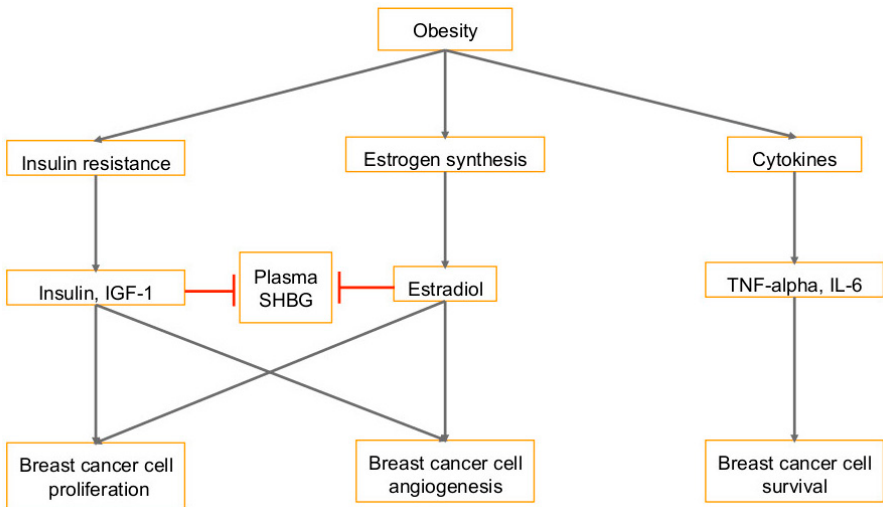
Figure 1. Pathways that link breast cancer with obesity: Several consequences of obesity, such as insulin resistance, higher levels of circulating estrogen, and secreted cytokines play a role in the development of breast cancer. Insulin and IGF-1 promote proliferation and angiogenesis by activating the PI3K/Akt and Ras/Raf/MAPK pathways. Insulin also inhibits sex-hormone-binding globulin (SHBG), which binds testosterone and estradiol so there is increased free estradiol. Circulating estrogens promote growth of breast epithelial cells and lead to more proliferation and angiogenesis as well. Adipocytes can secrete pro-inflammatory cytokines which stimulate more lipolysis and further release of free fatty acids to promote cancer cell survival. T-bars in red denote inhibition.